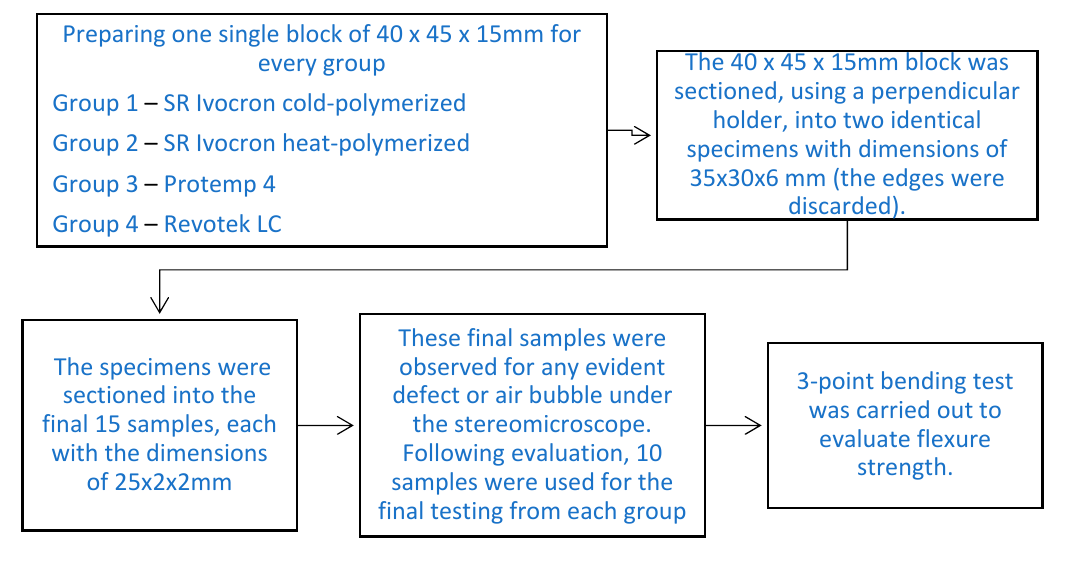
Figure 1. Sample preparation flow chart.